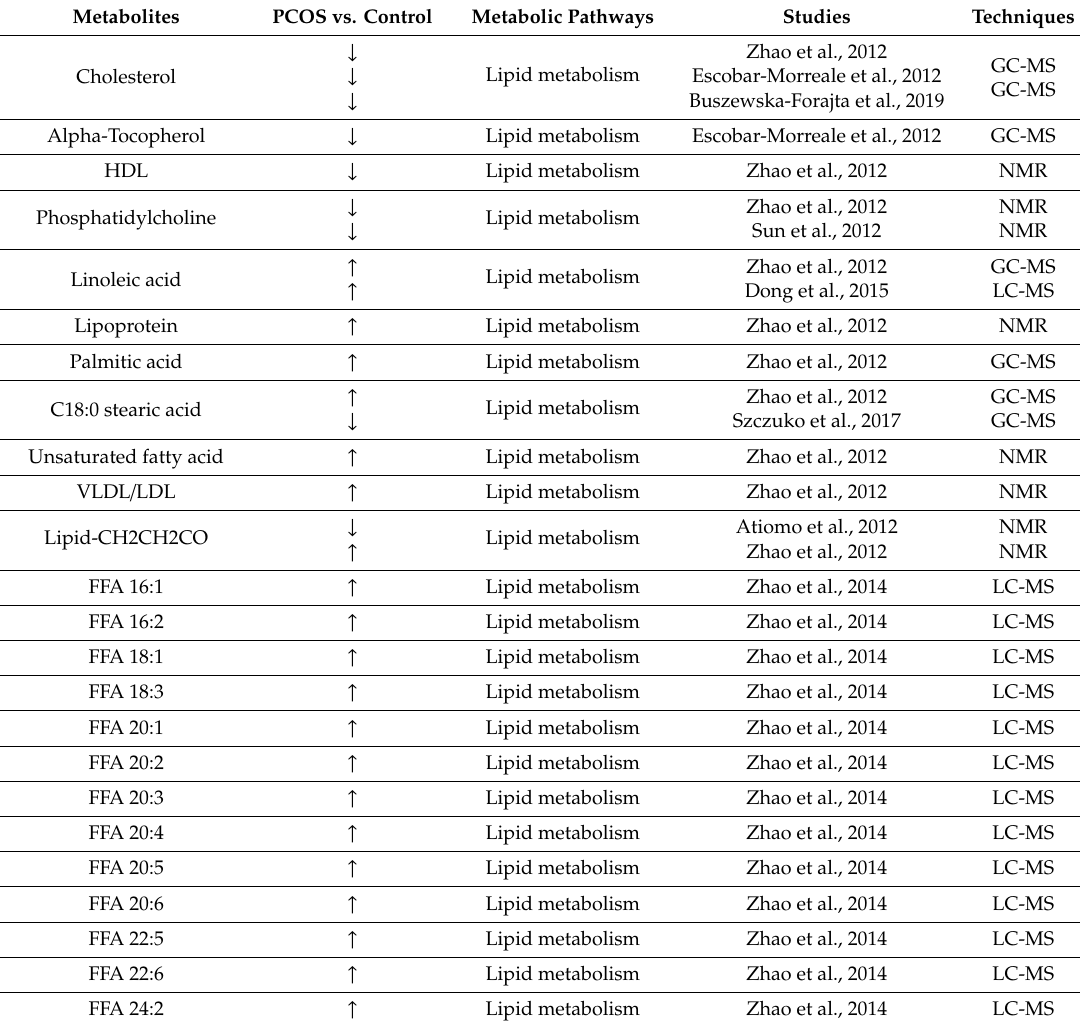
Table 1. The most significant changes in metabolites measured in plasma and serum samples in women with PCOS in comparison with control